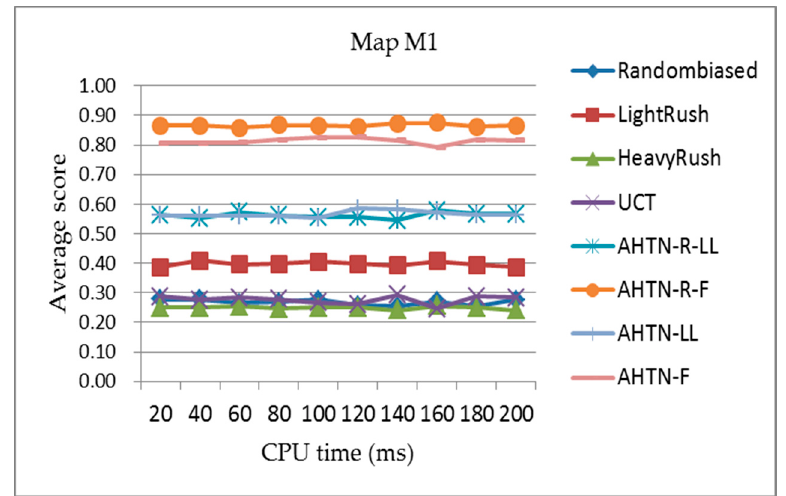
Figure 7. The average score of each algorithm obtained over the 800 games of the round-robin competition for map M1 (8 × 8 tiles) with respect to the CPU time from 20 to 200 ms. The playout time is 100 cycles.